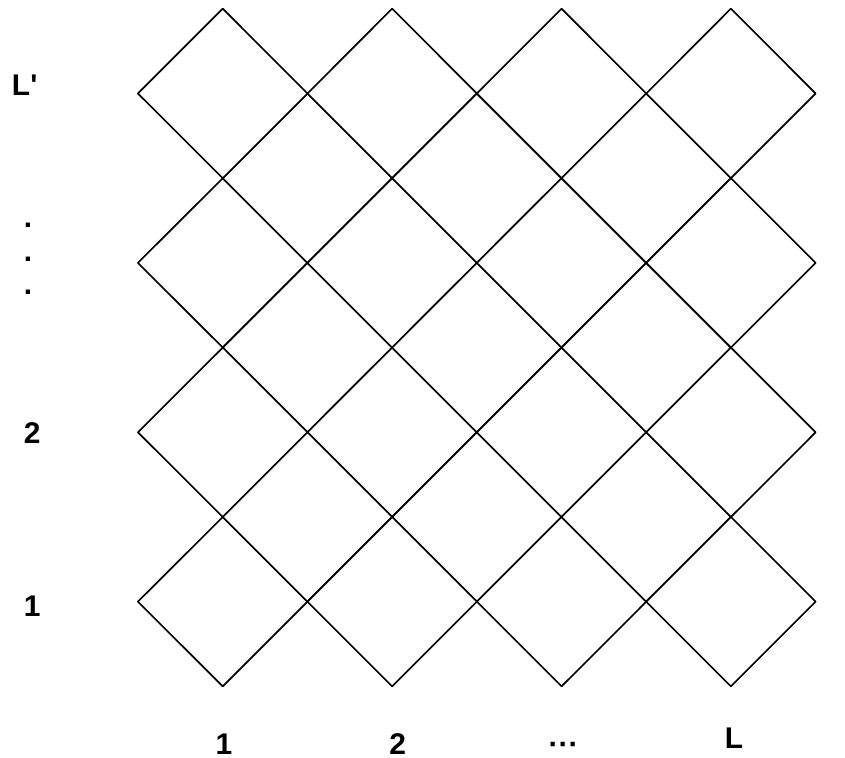
Figure 1 . Periodic Ising Lattice. The leftmost (lowermost) spins are identi(cid:12)ed with corresponding rightmost (uppermost)